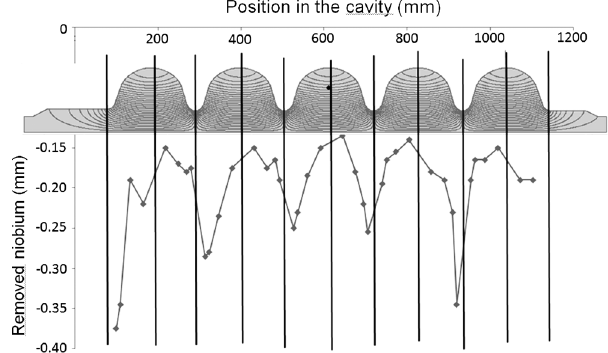
FIG. 13. Distribution of niobium removal after the four main VEP sequences, which corresponds to the removal of 200 μ m in